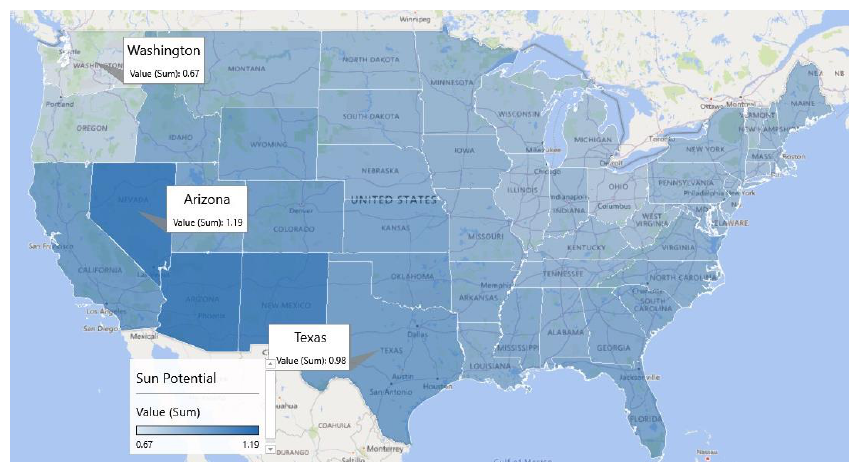
Figure 2. Choropleth of state solar production potential.